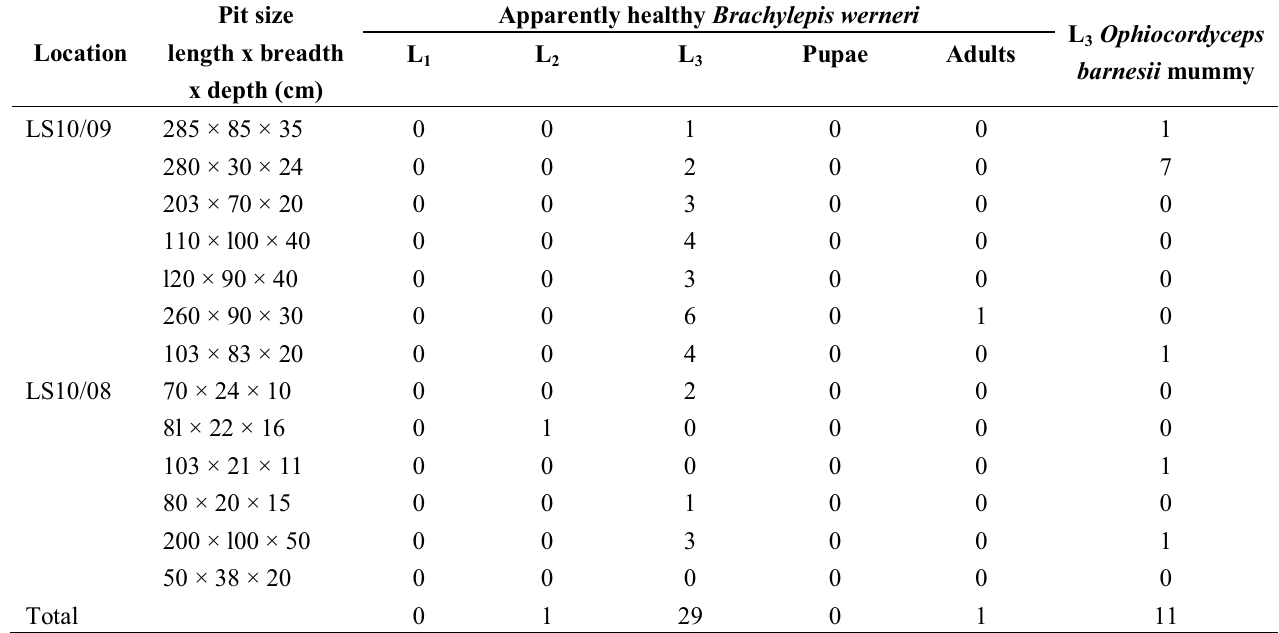
Table 12. Sampling for Brachylepis werneri and Ophiocordyceps barnesii , May